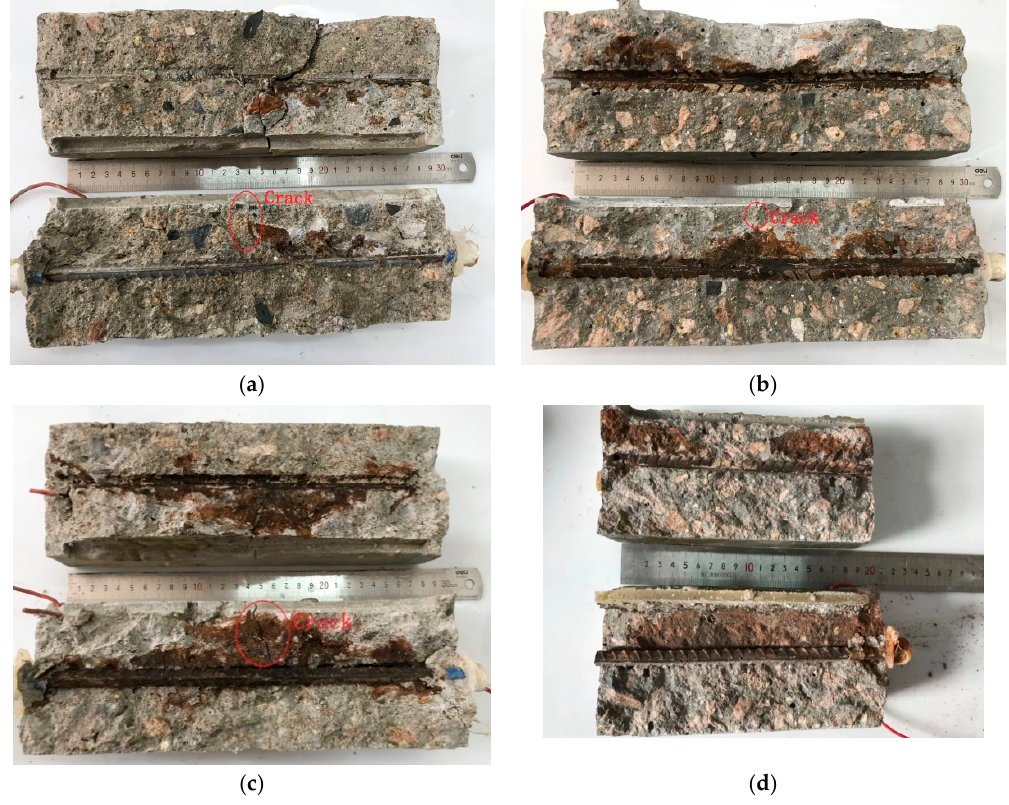
Figure 13. Corrosion production distribution area of concretes with CR steels. ( a ) Crack width (LC) = 0.10 mm; ( b ) Crack width (LC) = 0.15 mm; ( c ) Crack width (LC) = 0.20 mm; ( d ) Crack width (LC) = 0.30 mm.